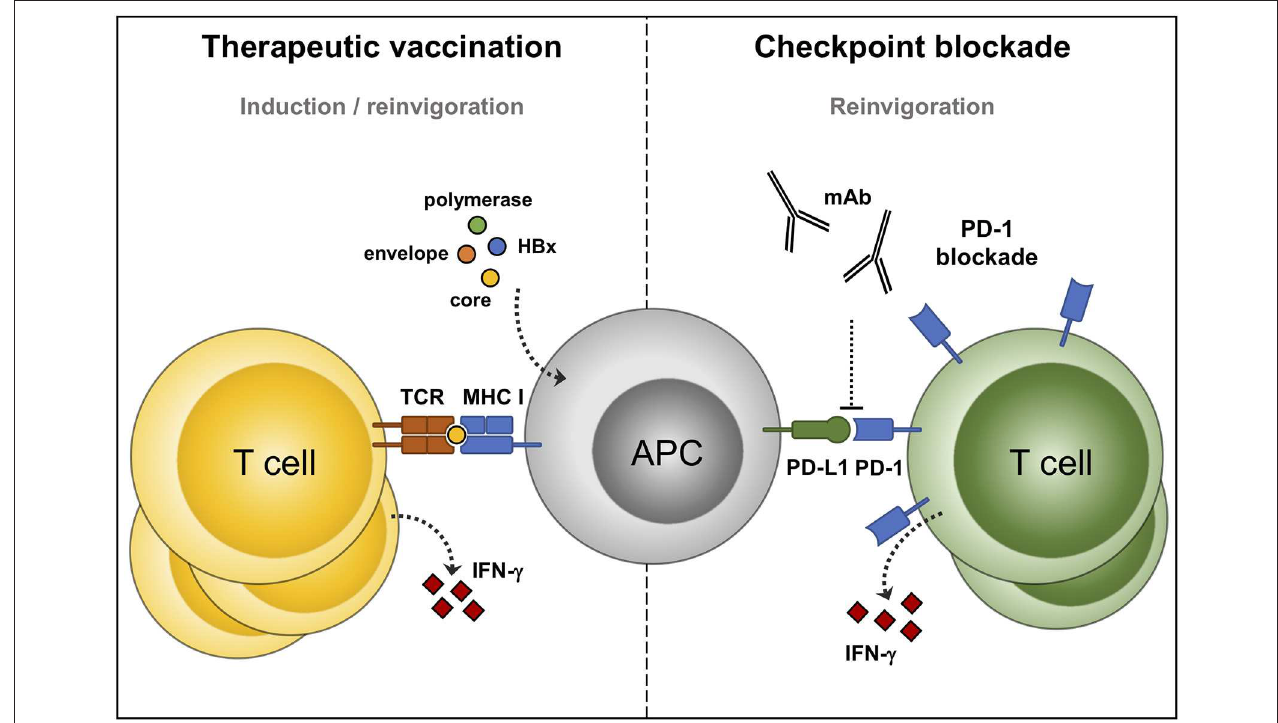
FIGURE 2 | Immunotherapeutic options to reinvigorate defective HBV-specific T cells. Therapeutic vaccines consist of, or express, HBV antigens. Processing of these antigens by professional antigen presenting cells (APC) can prime new, and reactivate pre-existing, HBV-specific T cells ( left panel ). Immune checkpoint inhibitors: monoclonal antibodies that prevent the interaction between programmed cell death protein-1 (PD-1) and its ligand, and boost the function of HBV-specific T cells ( right panel